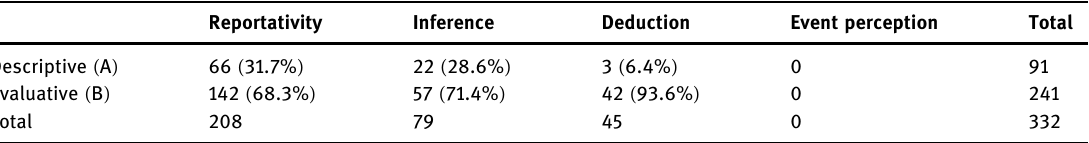
Table 6: Types of adjectives and evidentiality